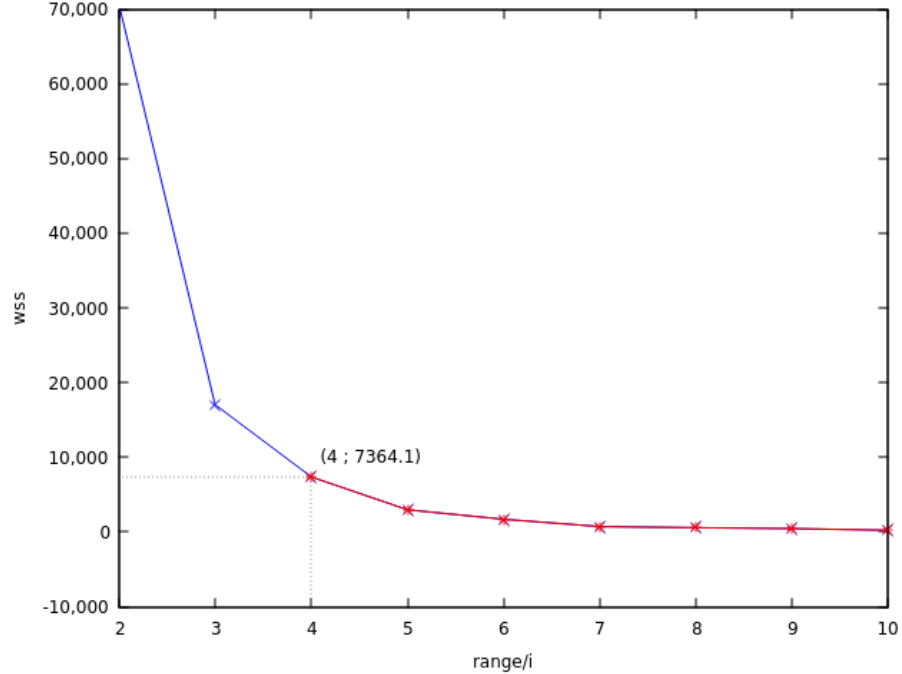
Figure 2. Minimum within-cluster sum of square measurements for different reductions.